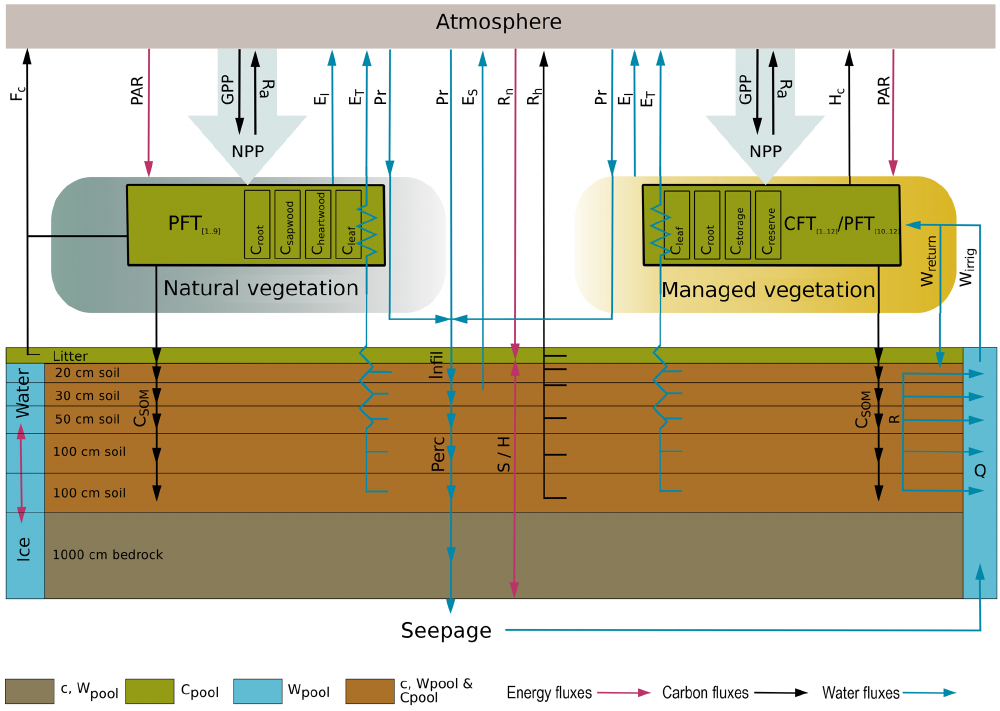
Figure 1. LPJmL4 scheme for carbon, water, and energy fluxes represented by the model. C – carbon; W – water; S – sensible